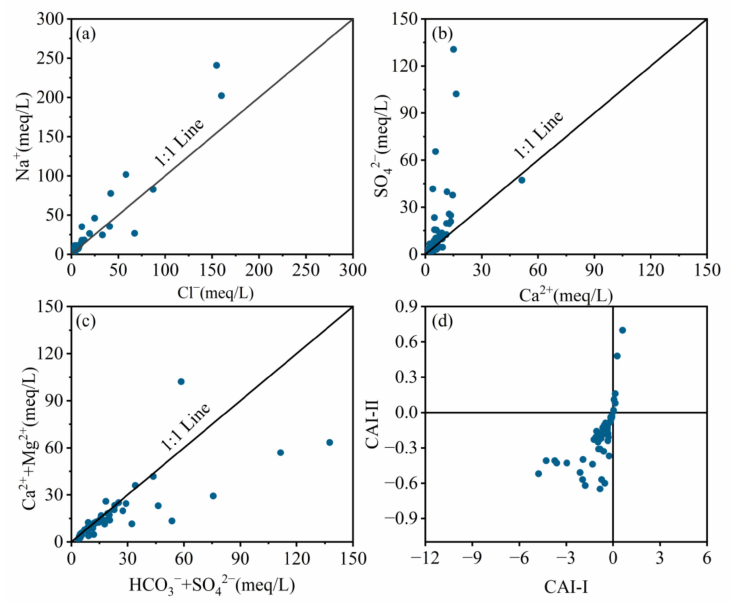
Figure 8. Ions correlation analysis picture of the Shizuishan